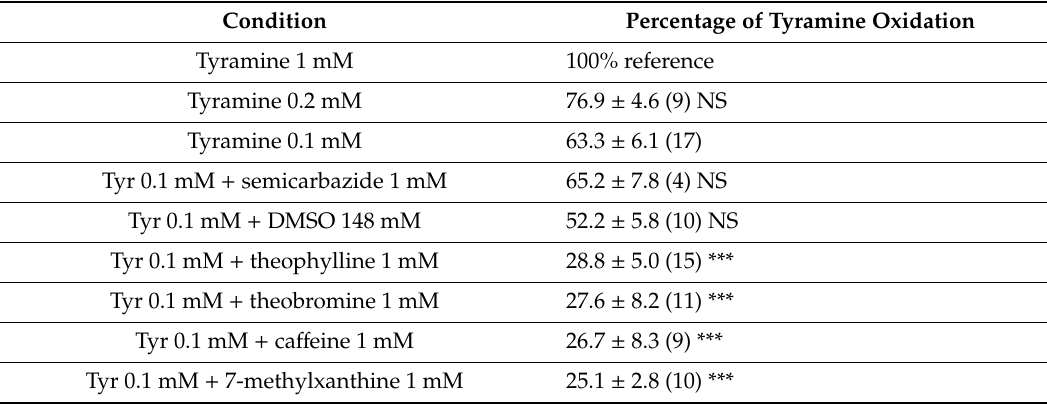
Table 1. Inhibition of the oxidation of 0.1 mM tyramine in human adipose